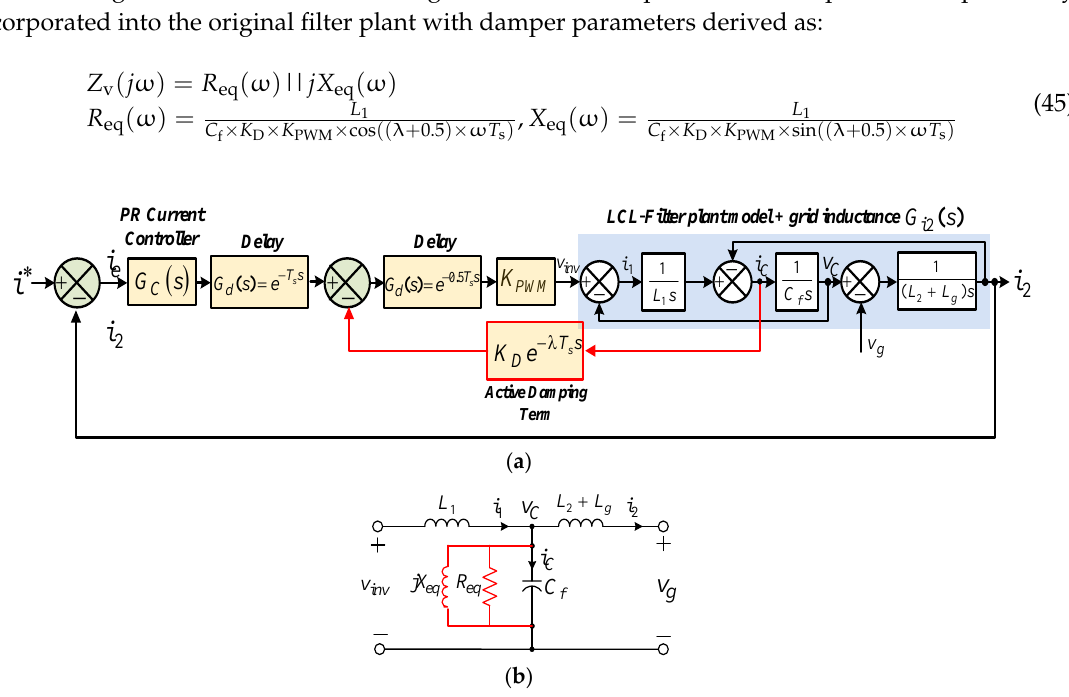
Figure 21. Block diagram and filter equivalent circuit of the digitally controlled LCL-filtered grid-connected inverter with the improved CCF AD scheme by reduced computation delay: ( a ) control diagram representation; and ( b ) filter equivalent circuit.